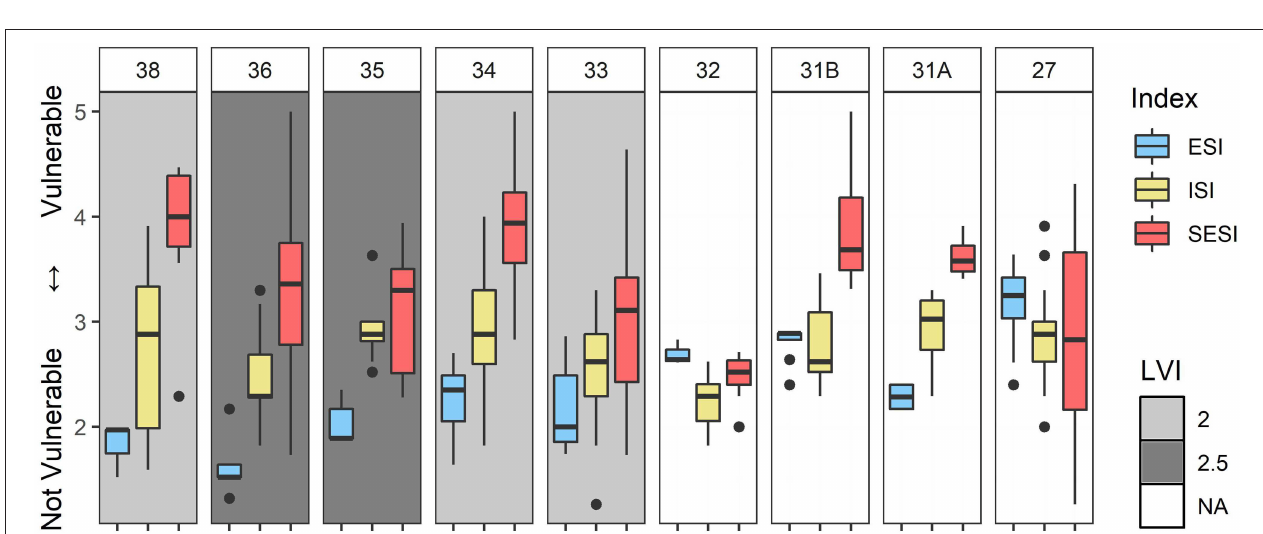
FIGURE 6 | Vulnerability sub-indices by Lobster Fishing Area (LFA). Boxplots show the distribution of index scores within each LFA: the colored boxes represent the interquartile range (the middle 50% of scores), the horizontal line represents the median score, points represent outliers (values that exceed the upper or lower quartile by 3/2 times, whiskers (vertical lines) represent the maximum and minimum scores (excluding outliers). Boxplots represent distributions of Exposure Sub-Index (ESI), Infrastructure Sub-Index (ISI), and Socio-Economic Sub-Index (SESI) scores among Small Craft Harbors within each LFA. Background shading represents the Lobster Vulnerability Index (LVI) per LFA. There is no LVI for LFAs 27, 31A, 31B, and 32 because there are no offshore lobster fisheries in these regions.